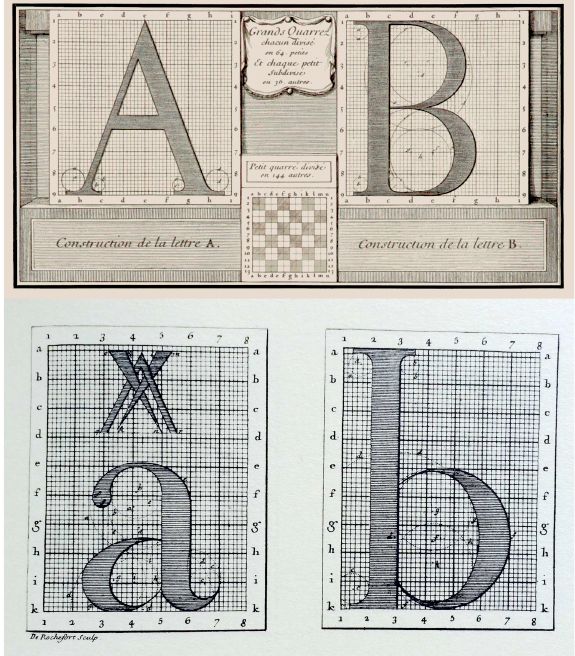
Figure 1. Roman du Roi, uppercace and lowercase